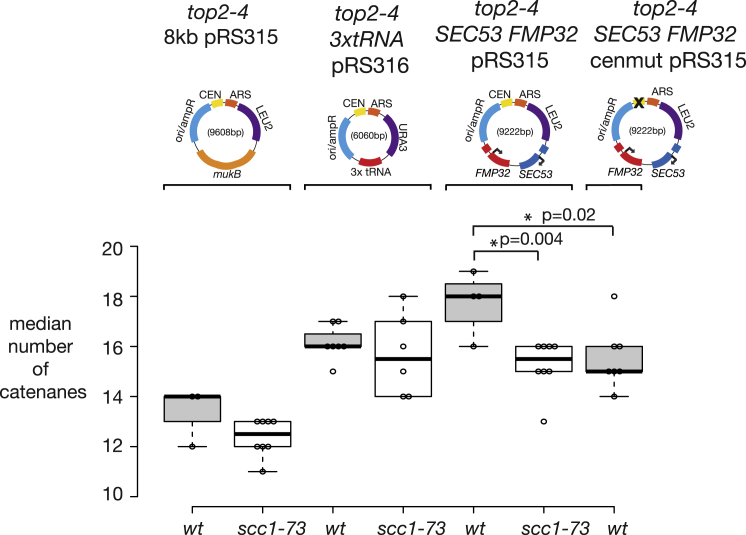
Cohesin Activity Increases Fork Rotation during DNA Replication of Plasmids with Active Transcription UnitsThe frequency of fork rotation on the different plasmid replicons was examined by gel electrophoresis and Southern blotting as described in STAR Methods. Cells containing the top2-4 allele and a CEN plasmid (8 kb pRS315), a CEN plasmid and 3× tRNA genes (3×tRNA pRS316), and a CEN plasmid with two active genes in a converging orientation (SEC53 FMP32 pRS315) were assessed for DNA catenation following one round of DNA replication in the absence of Top2 activity and with or without active cohesin (WT with active cohesin, scc1-73 inactive cohesin). 3×tRNA pRS316 WT sample was taken from Schalbetter et al. (2015). The CEN plasmid with two active genes in a converging orientation, SEC53 FMP32 pRS315, was also modified to inactivate the centromere by a double point mutation (Jehn et al., 1991), SEC53 FMP32 cenmutpRS315, and assessed for DNA catenation following one round of DNA replication in the absence of Top2 activity. Representative autoradiograms of the SEC53 FMP32 pRS315 plasmid with and without active cohesin and the SEC53 FMP32 cenmutpRS315 plasmid are shown in Figure S6. The relative intensity of catenanes generated post-replication was quantified and the population median of the catenanes calculated for each of the conditions. The median of each experiment is plotted on the boxplot along with the boxes representing the middle two quartiles of the distributions of the dataset. p values are derived from paired t tests; a star indicates a significant difference between two conditions (p < 0.05). See also Figures S5 and S6.